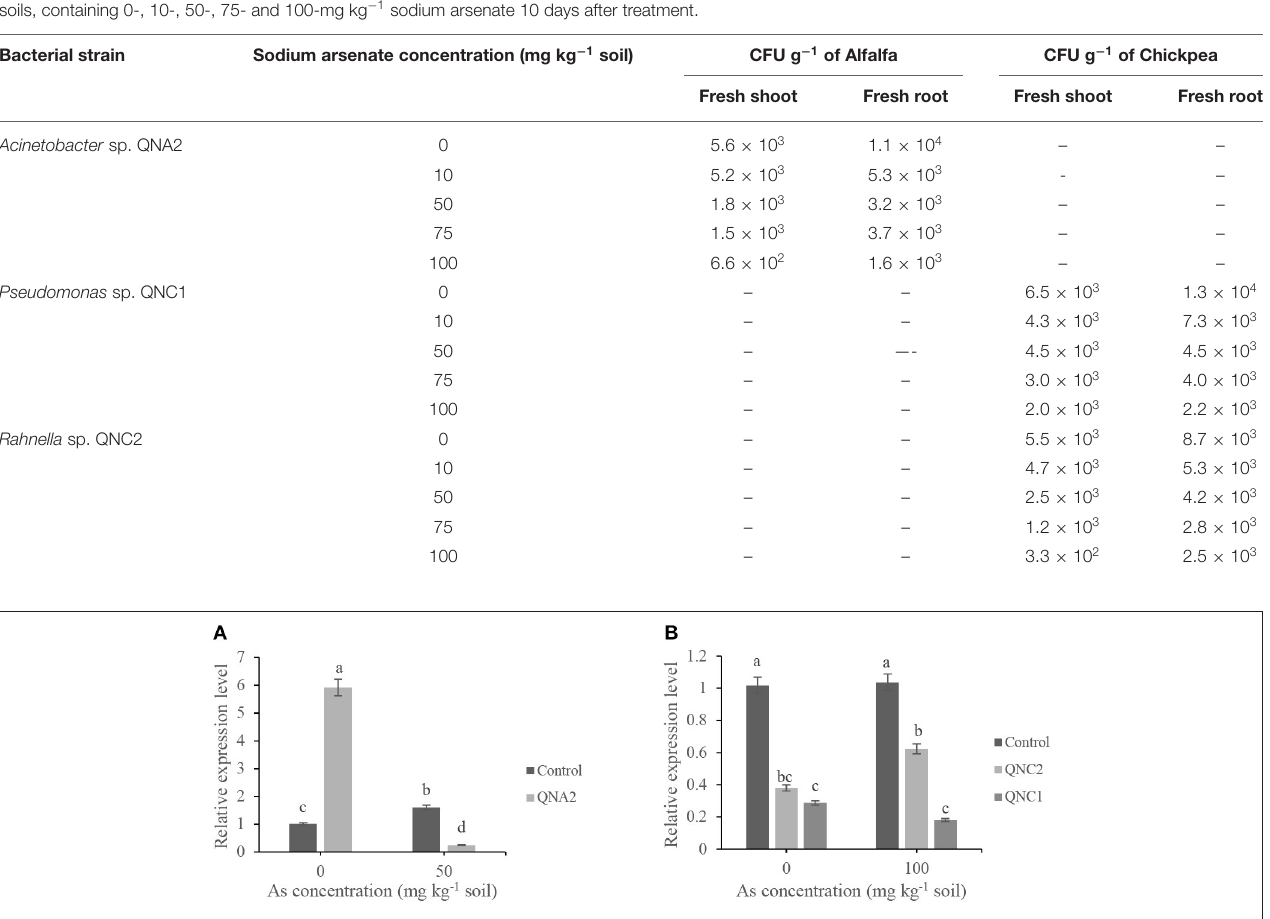
( Figure 6A ). Significant differences were observed between the expression level of the NPR3 gene in the roots of chickpea plants treated by QNC1 and QNC2 strains compared with the